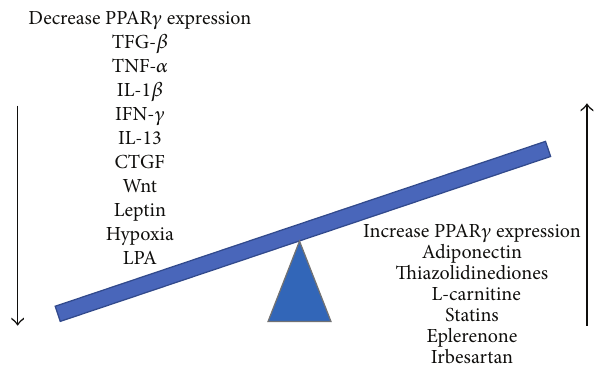
Figure 1: Effects of different molecules on PPAR 𝛾 expression.